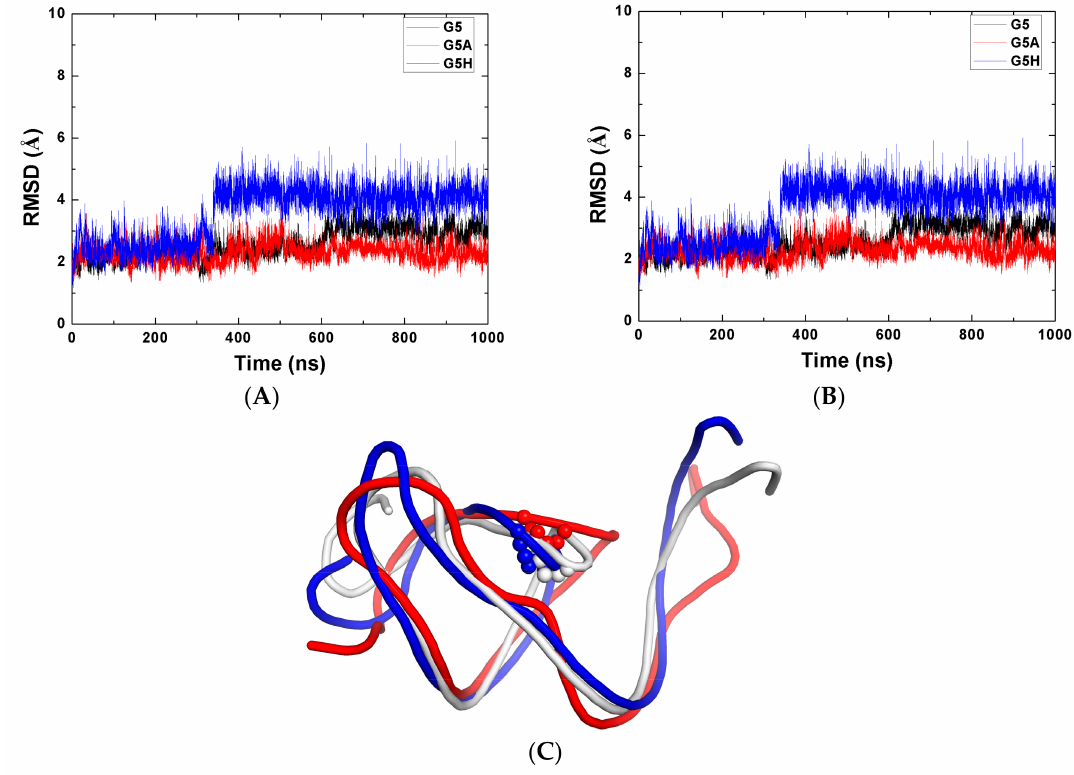
Figure 5. The RMSDs were calculated for the backbone atoms with the nucleotide numbers from 5 to 31 ( A ) relative to their original structure, and ( B ) for the atoms with nucleotides within 5 Å. ( C ) Superimposition of the representative structures of G5 (ToxI monomer in white color), G5A (mutated G5 to A5 in red color), and G5H (a hydrogen atom instead of nucleobase of G5 in blue color). Six atoms, which can show the position of nucleotide 5, are shown in ball